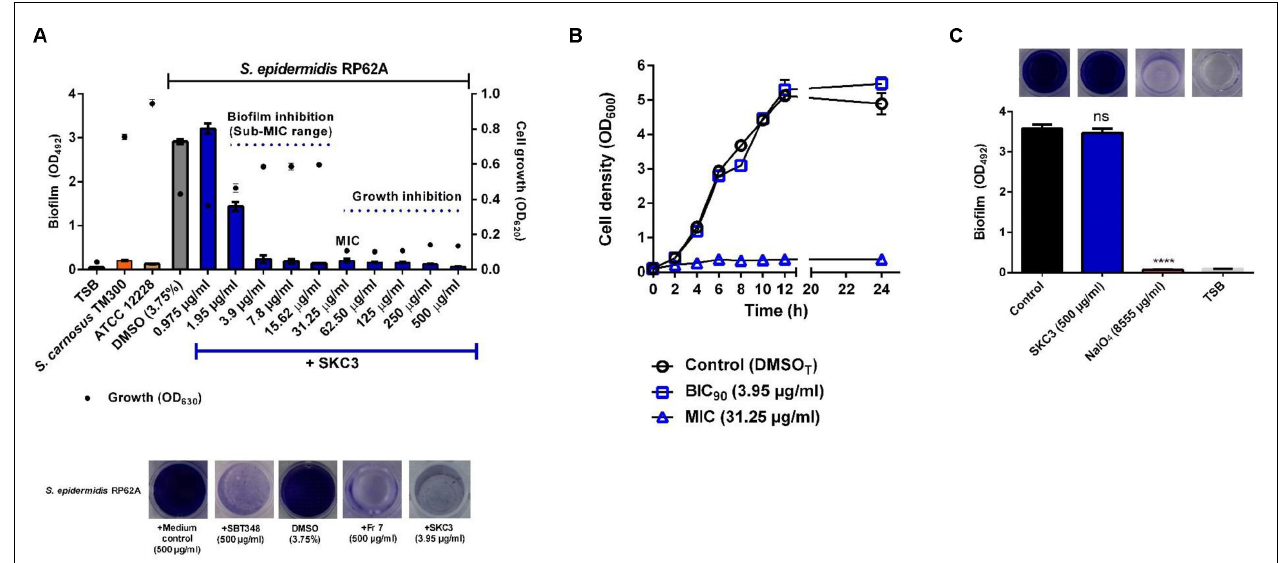
FIGURE 3 | (A) Inhibition of growth (MIC: 31.25 µ g/ml) and biofilm formation (sub-MIC range: < 31.25 µ g/ml) of Staphylococcus epidermidis RP62A. Controls consisted of biofilm negative strains S. epidermidis ATCC 12228, S. carnosus TM300, DMSO treated S. epidermidis RP62A, and sterile TSB without bacteria. (B) Effect of SKC3 on growth (OD 600 ) at MIC (31.25 µ g/ml) and BIC 90 (3.95 µ g/ml), respectively. DMSO treated S. epidermidis RP62A was the appropriate control in the growth curve analysis. (C) Influence of SKC3 on pre-formed (existing) biofilms of S. epidermidis RP62A. NaIO 4 that digests the polysaccharide biofilms was used as the positive control. All the experiments were repeated at least three times in multiple technical replicates. ns, not significant; ∗∗∗∗ p <